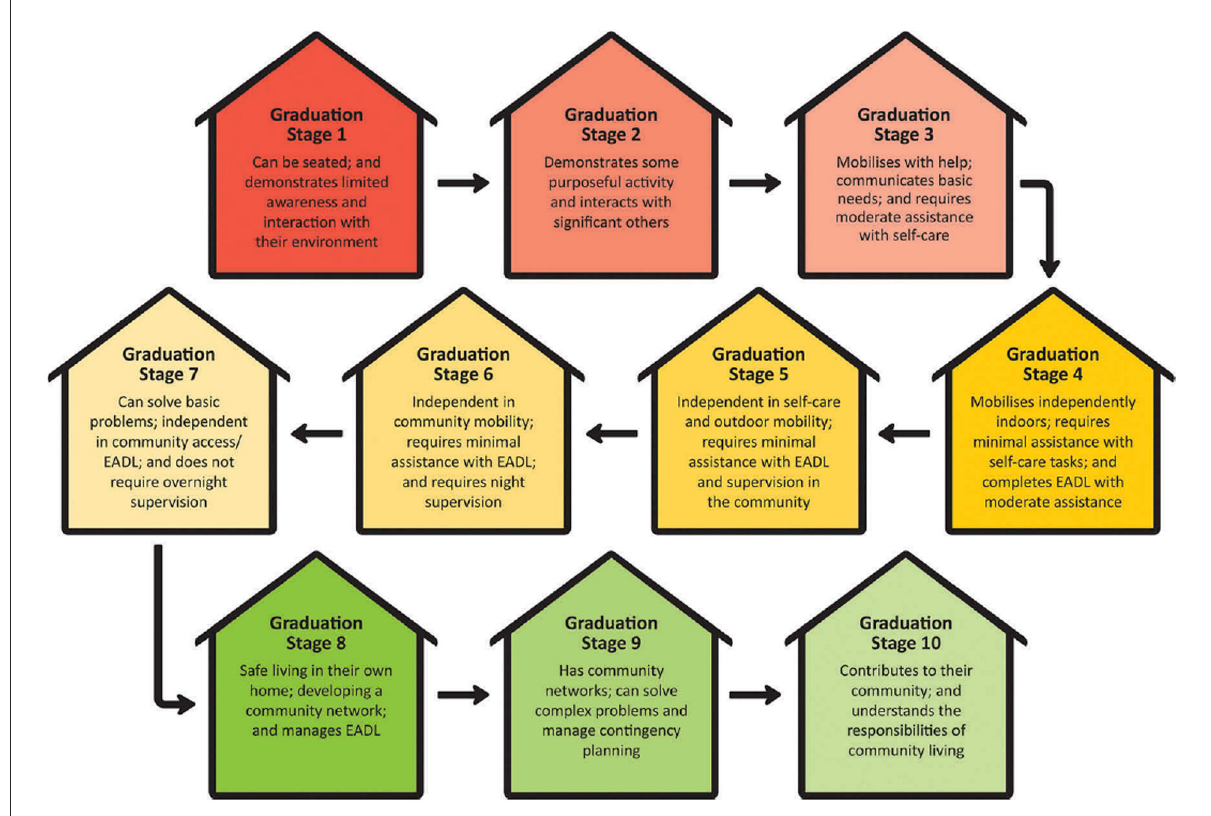
FIGURE1 Staged community-based brain injury rehabilitation (SCBIR) graduation